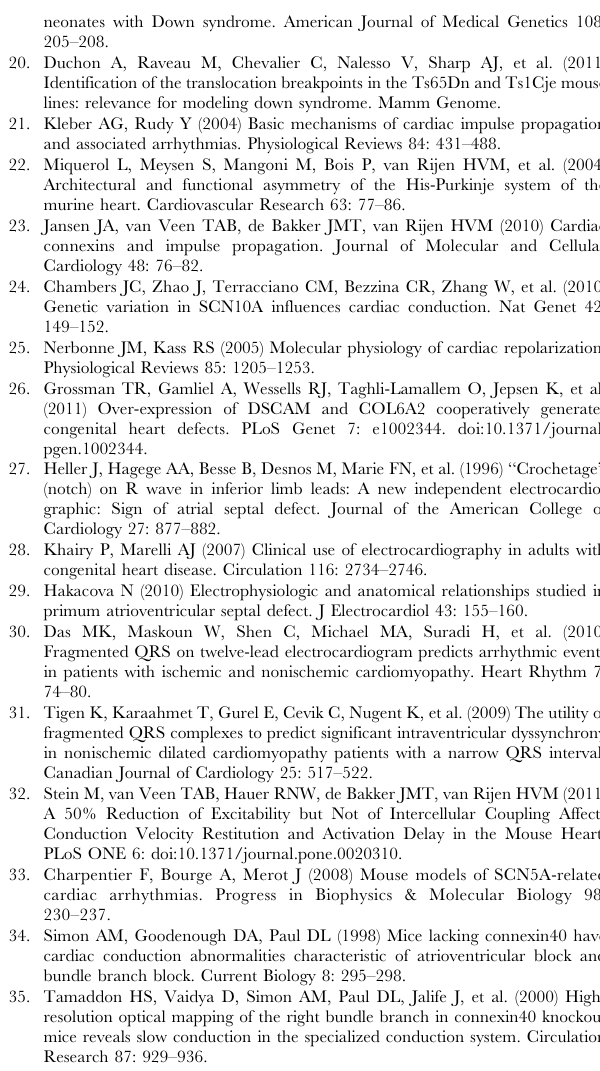
Figure S1 Ms5Yah mouse model creation and validation. App- Runx1 region (A) on Mmu16 was targeted for in vivo Cre/loxP recombination by inserting a loxP site on App locus in Runx1 tm1Yg (B). Recombination using Tg(Pgk1- cre )1Lni led to deletion of the floxed fragment creating Ms5Yah mouse model. Chimeras and monosomic mice were distinguished using Southern Blot genotyping (C) and the deletion was confirmed by CGH arrays (D). Table S1 List of deregulated genes in Affymetrix hybridization arrays. This list was obtained by using ANOVA with Bonferroni correction and fixing a threshold of P , 0.1. Genes in pink. orange and blue are genes located respectively within the centromere- Pde10a region on Mmu17. the Mrpl39-Runx1 and Runx1-Zfp295 region on Mmu16 trisomic in Ts65Dn mice. We calculated the mean, the standard error to the mean for the expression ratio and the Student-t-test comparing mutant versus wt and annotated with * if P , 0.05. ** if P , 0.01 and *** if P , 0.001. Overexpressed genes with an expression ratio . 1.2 are underlined in red whereas